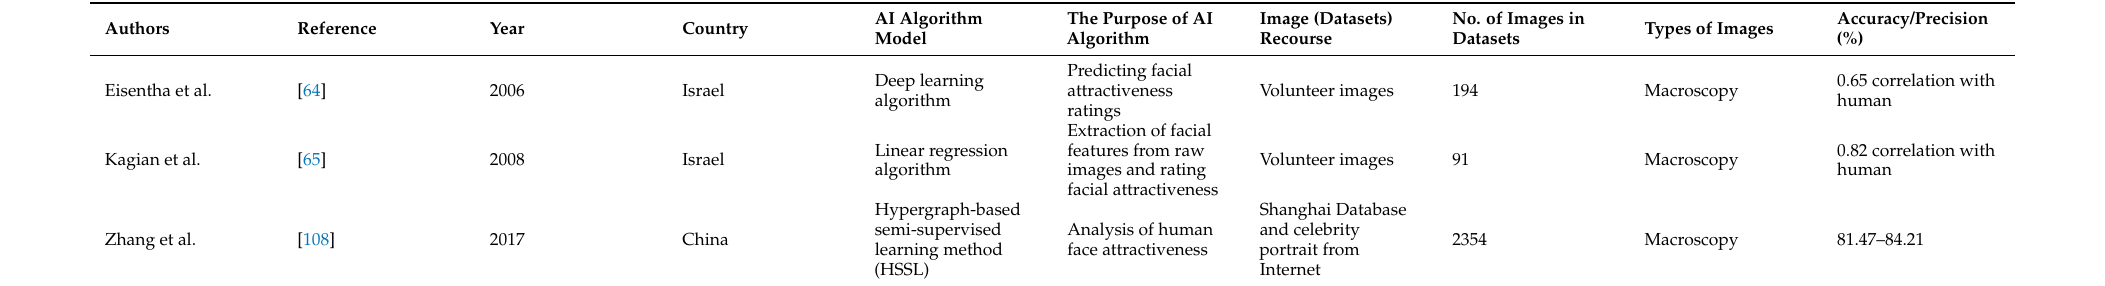
Table 4. The application of AI in aesthetic